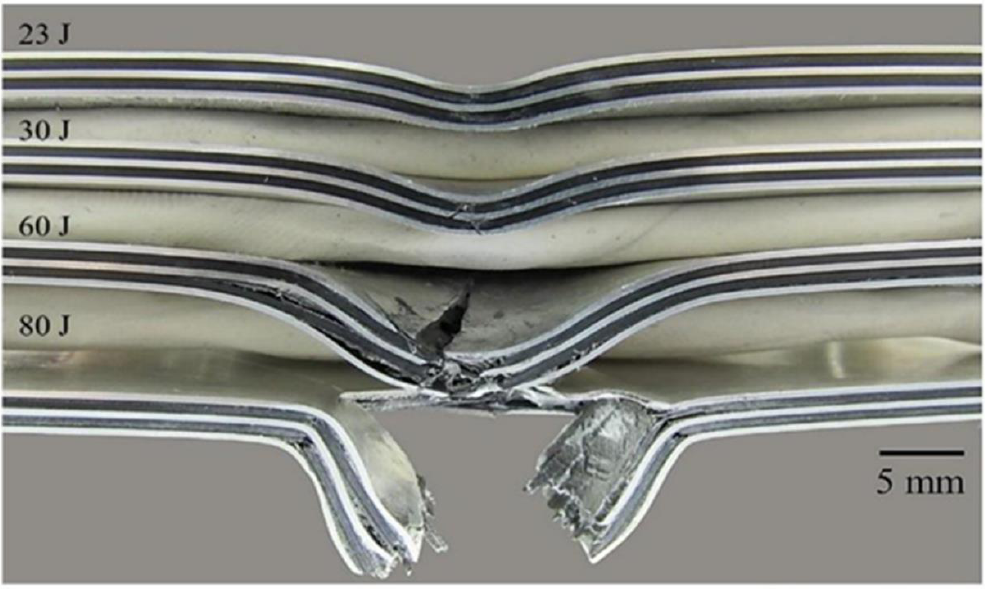
Figure 12. Cross sections of FML 3/2 at different impact energies.